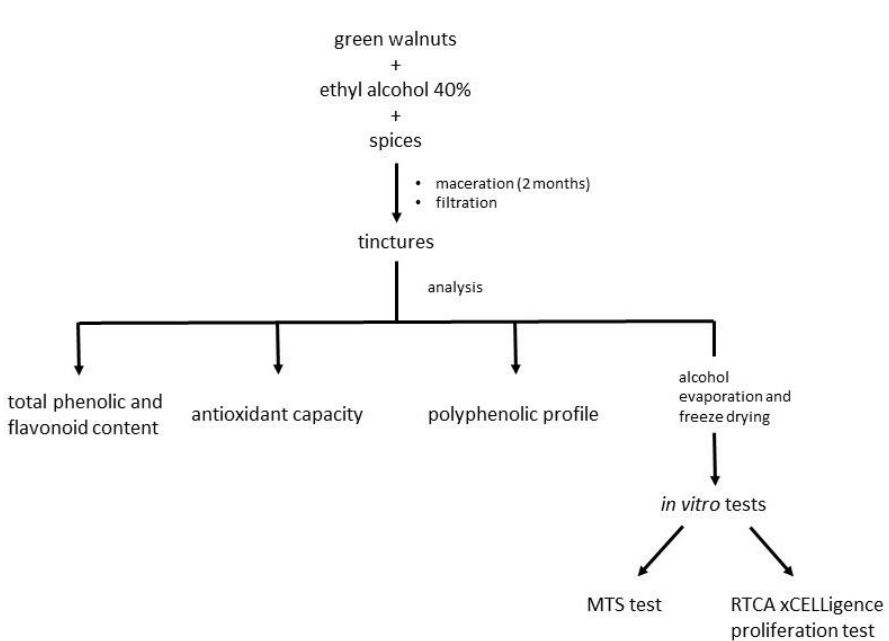
Figure 1. The scheme of the experiment.